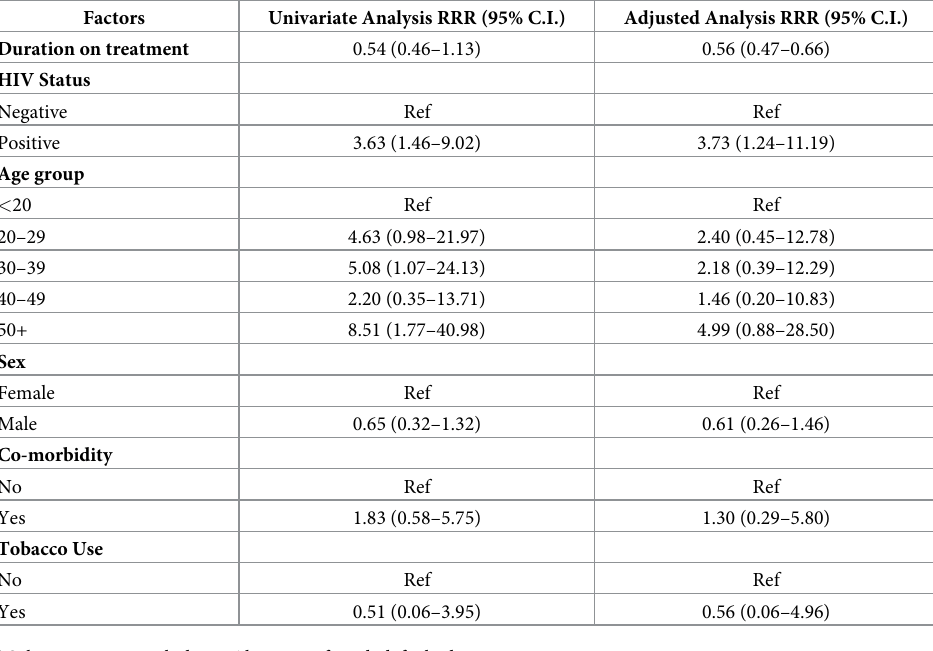
Table 3. Risk factors associated with death among TB patients presenting for care at Elim